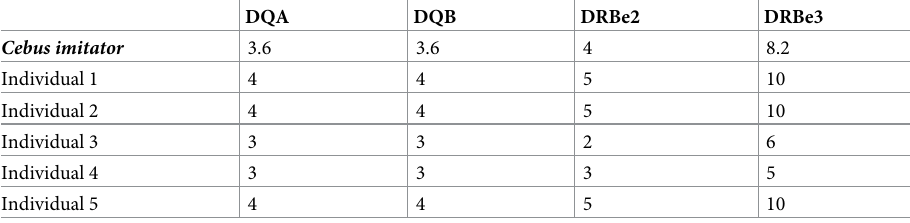
Table 3. Mean and total numbers of MHC alleles per individual with duplicate PCRs.